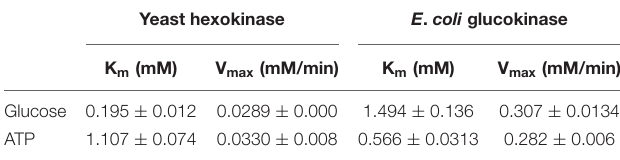
TABLE 1 | Kinetic parameters of yeast hexokinase and E . coli glucokinase. Yeast hexokinase E . coli glucokinase